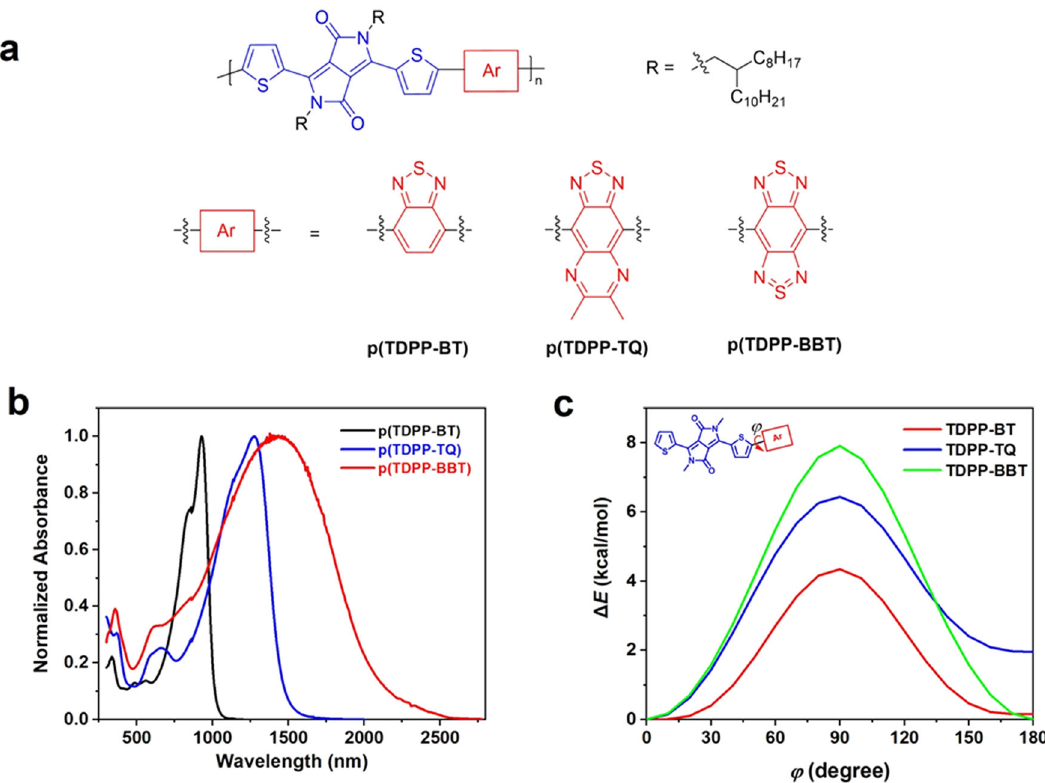
Fig. 3 Chemical structure and characterization. a Molecular structures of three semiconducting polymers. “ Ar ” is the aromatic building block. b UV – vis – NIR absorption spectra of the polymers in ODCB solution (1 × 10 − 5 M). c Calculated potential energy scans (PES) of the dihedral angles φ between the TDPP and three BT